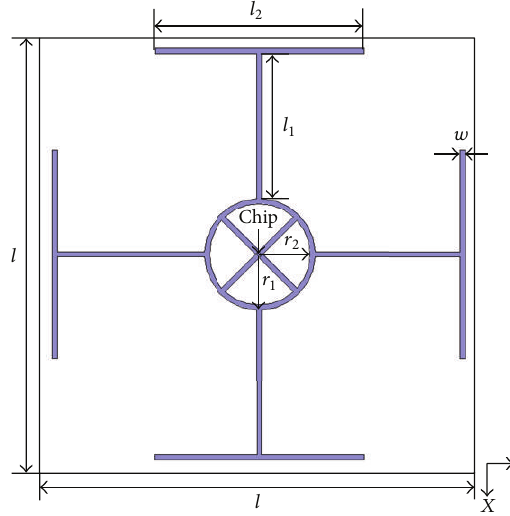
Figure 4: Structure of the one-fold dual-dipole tag antenna. The substrate of the antenna is made of PTFE, with an area of 𝑙 × 𝑙 and a thickness of ℎ